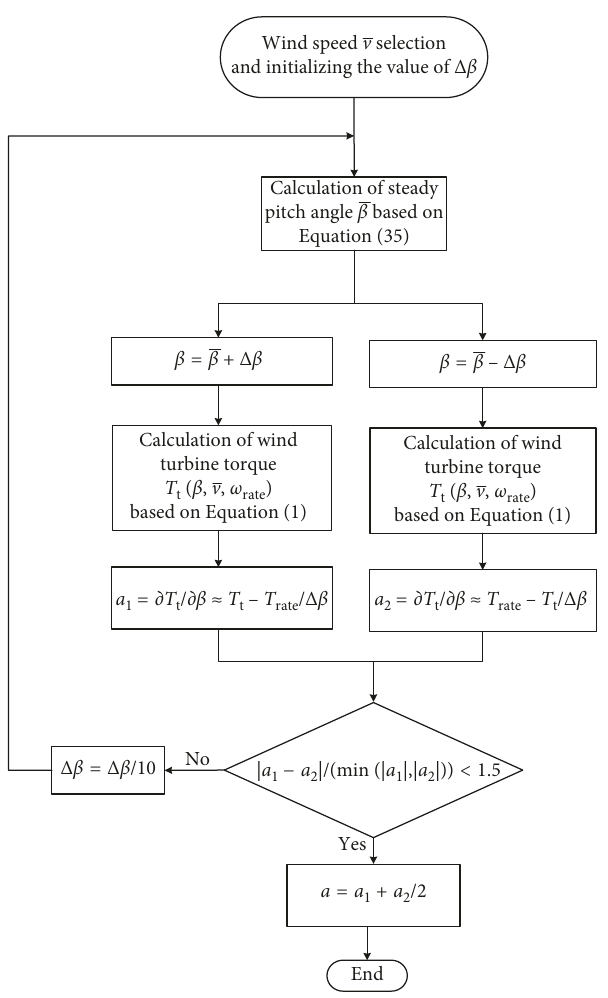
β β is 0.01 ° ). Δ Δ